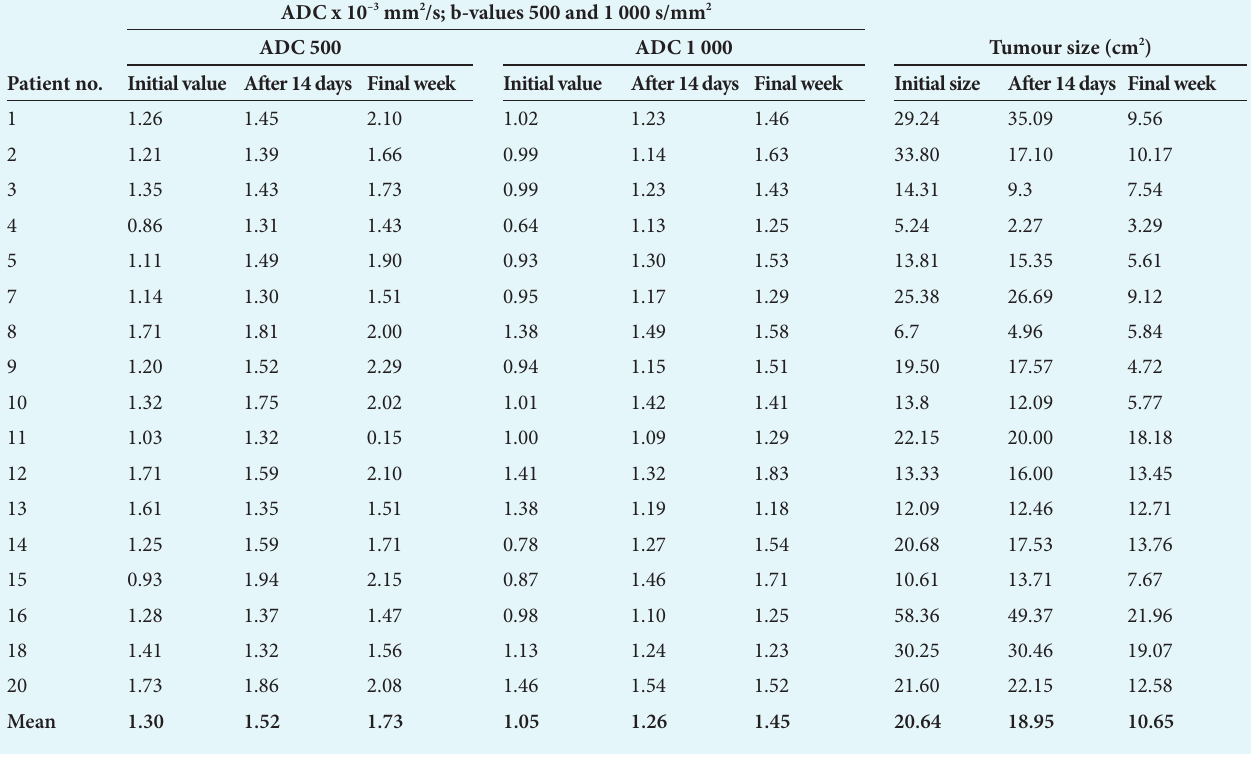
Table 1. Comparison of ADC values in axial plane with b-values of 500 and 1 000 s/mm 2 and tumour size in women with cervical cancer, FIGO staging IIB - IVB